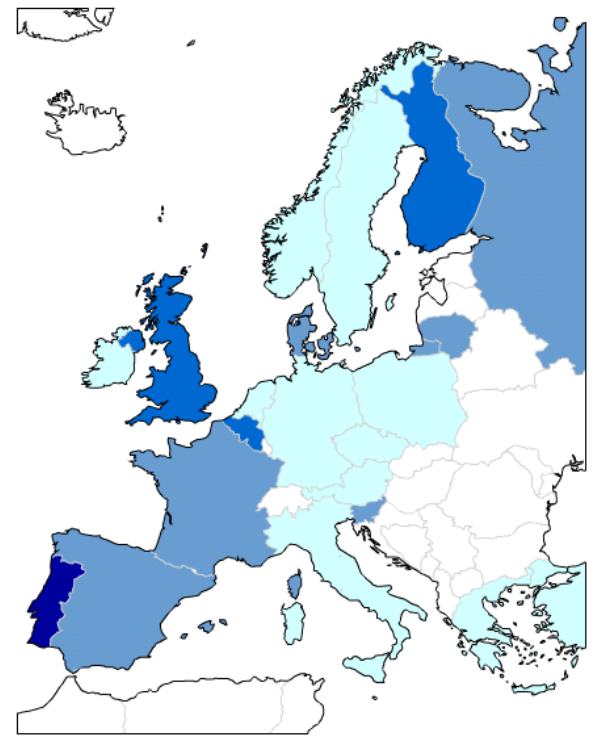
Figure 1 . Geographical distribution of institutions